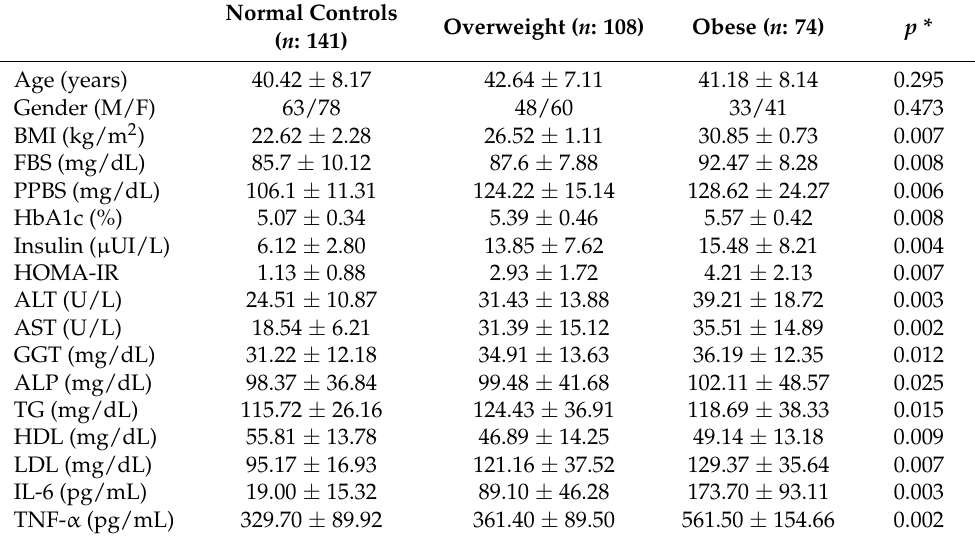
Table 1. Distribution of demographic and laboratory data in the individuals included in the study (Mean ± SD). Normal Controls Overweight ( n : 108) Obese ( n : 74) p * ( n : 141)